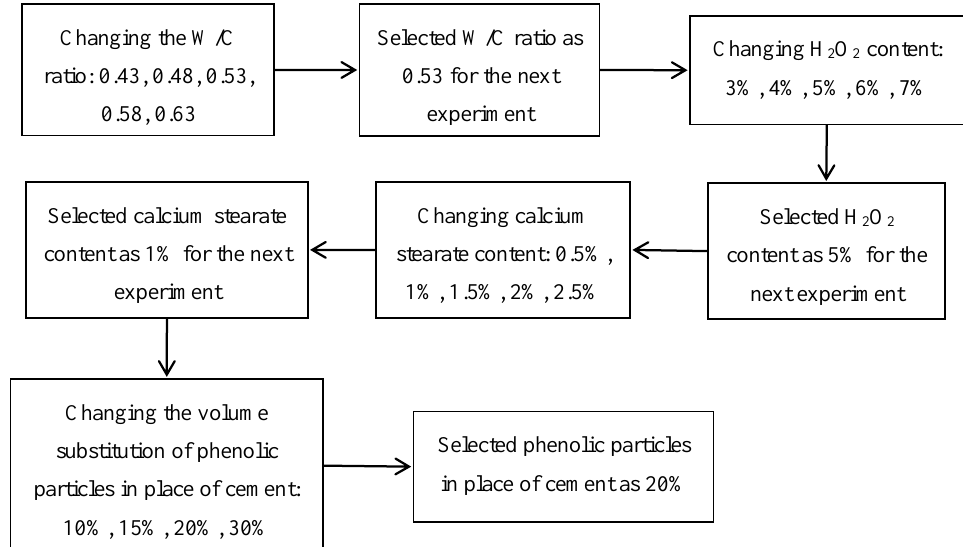
Figure 1. Foamed concrete proportioning design. Note: H 2 O 2 content/calcium stearate content refers to H 2 O 2 /calcium stearate mass percentage of cement mass.